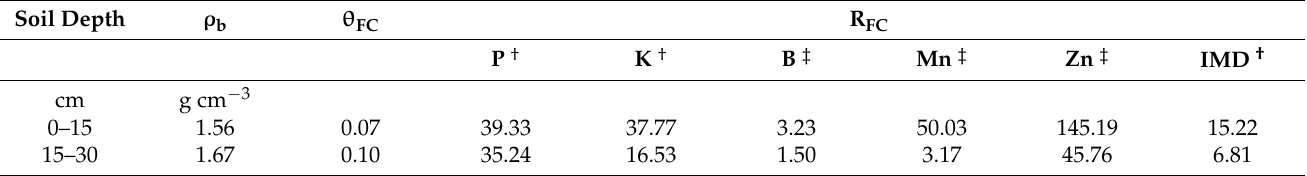
Table 2. Retardation factor of nutrients and